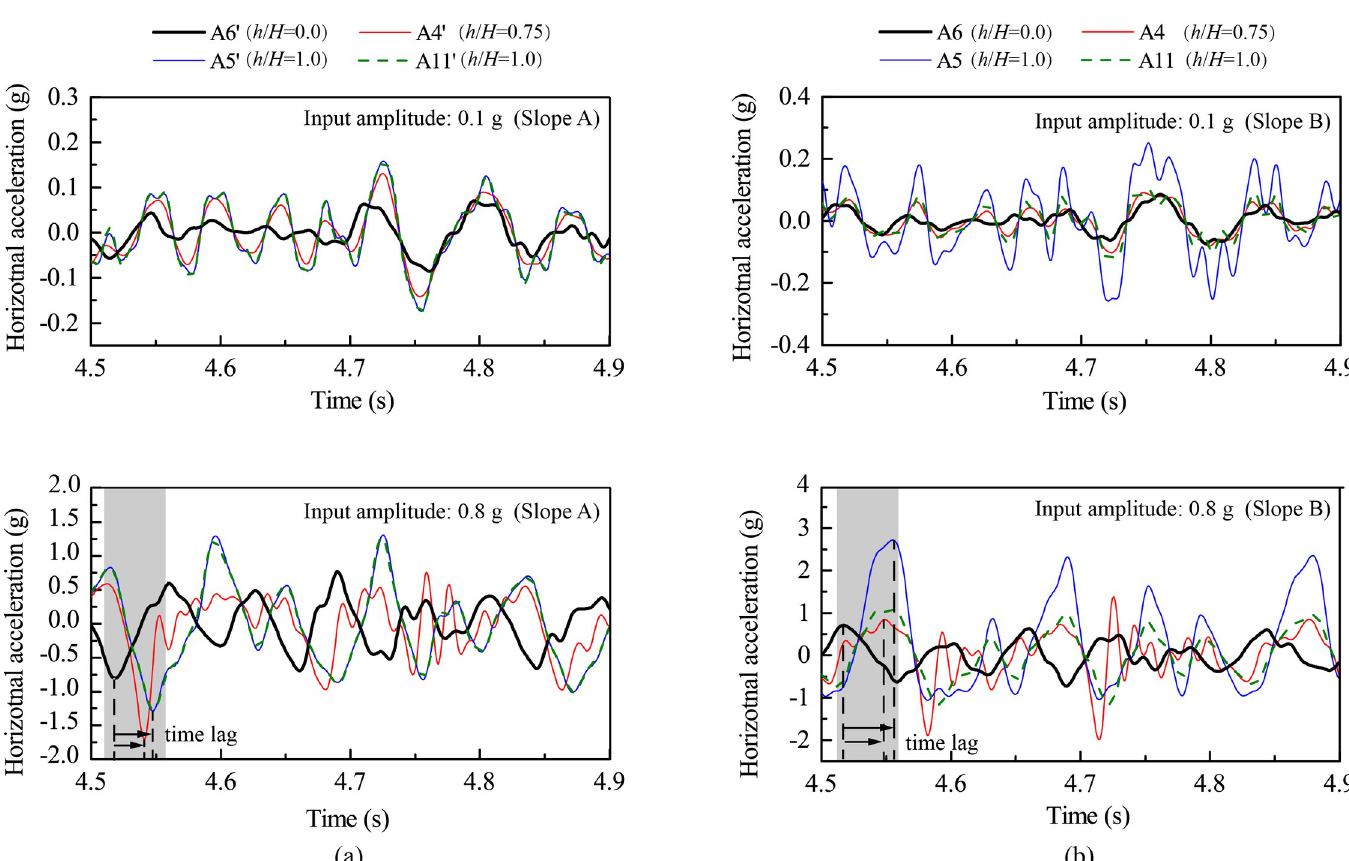
Fig 5. Horizontal acceleration responses at selected monitoring points under 0.1 g and 0.8 g levels of horizontal shaking: (a) Slope A; (b) Slope B.